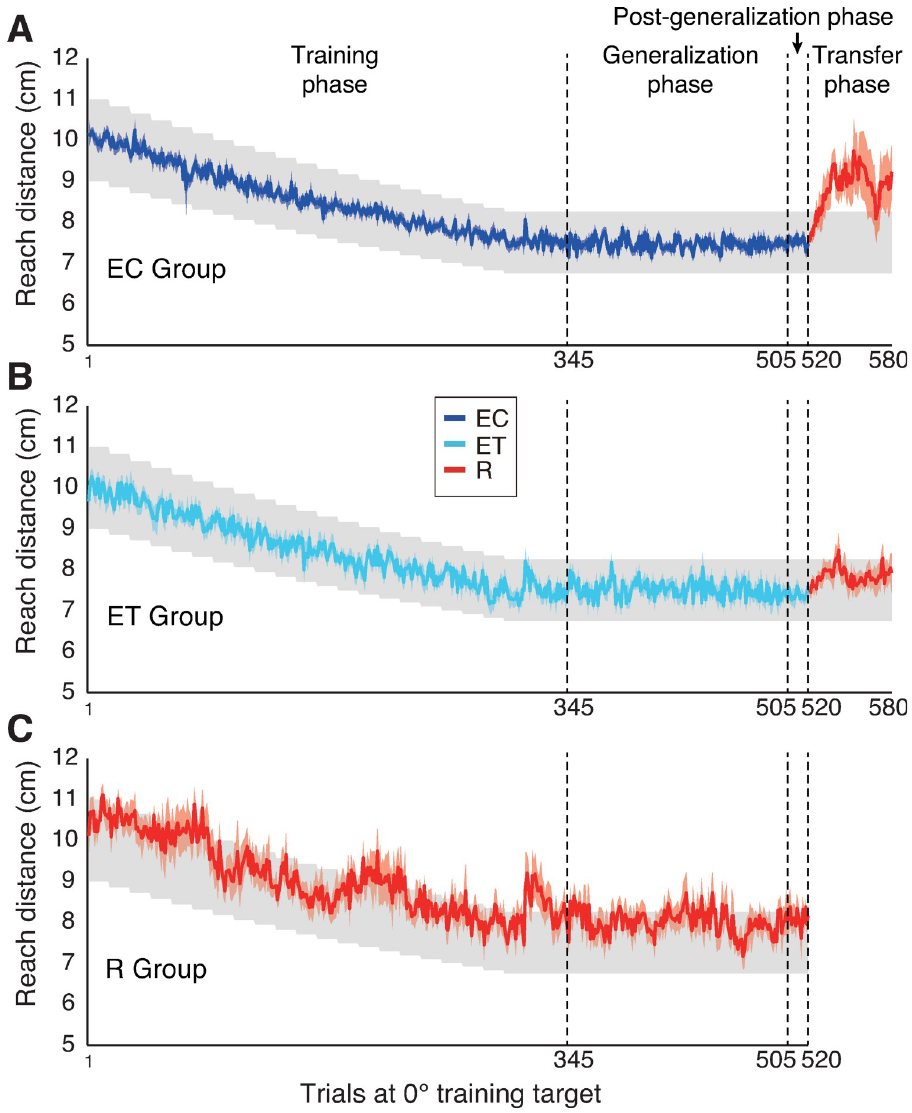
Fig 2. Time course of adaptation. (A-C) Hand reach distance in trials with the 0˚ training target, across the different phases of the experiment, for the EC, ET, and R groups. The colored lines and shading show the mean and SE for each group. The grey shading shows the reward